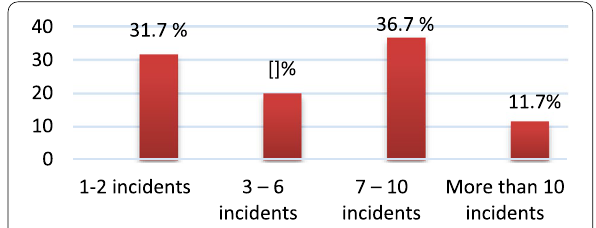
Fig. 2 The incidents of bullying in school that teachers witness and/ or report in school ( n 60) =